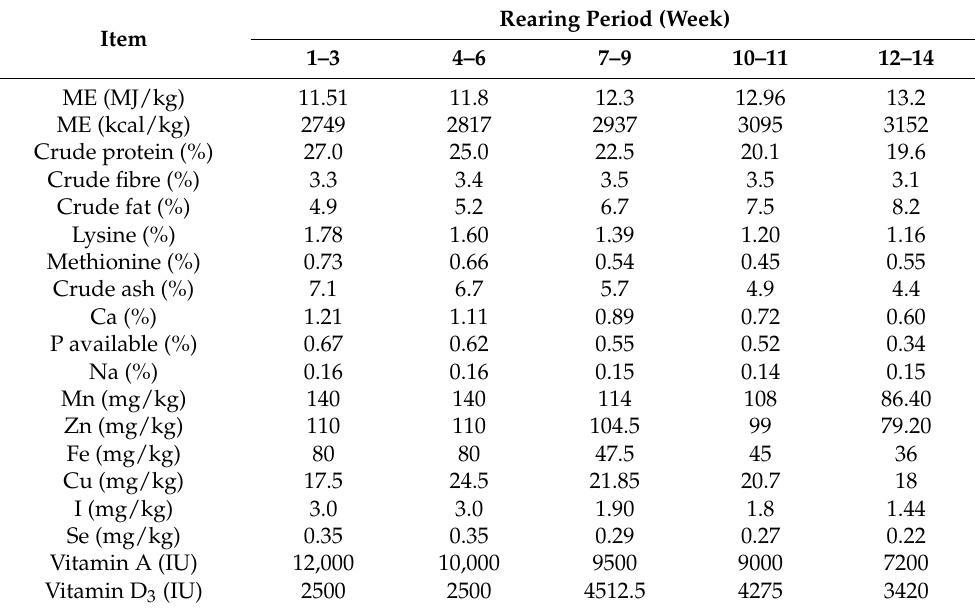
Table 1. Nutritive value of mixtures